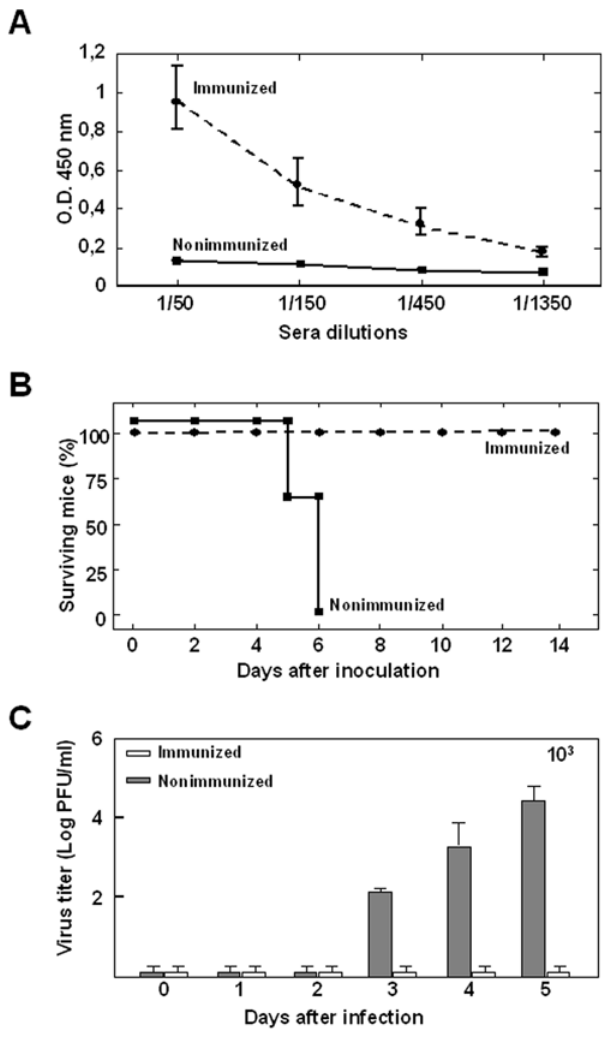
Figure 5. Protection of vaccinated IFNAR ( 2 / 2 ) mice against a lethal BTV-4 challenge. Mice (8 weeks old, 8 per group) were immunized twice by subcutaneous administration of an inactivated BTV-4 vaccine and inoculated with 10 3 PFUs of BTV-4,. (A) ELISA detection of antibodies to BTV-4 VP2 in serum of immunized and nonimmunized IFNAR ( 2 / 2 ) mice. Serum was collected two days before the challenge with BTV-4, and dilutions (1:50 to 1:1350) were analyzed by ELISA as described in Materials and Methods. (B) Survival rates of immunized and nonimmunized IFNAR ( 2 / 2 ) mice after inoculation with BTV-4. The mice were observed every 24 h for 14 days. (C) Titers of BTV- 4 recovered in blood of immunized and nonimmunized IFNAR ( 2 / 2 ) mice after challenge with BTV-4. Virus was extracted from blood and determined as described in Materials and Methods. Each point represents the mean values of the viral titer of eight animals, and standard deviations are shown as error bars.